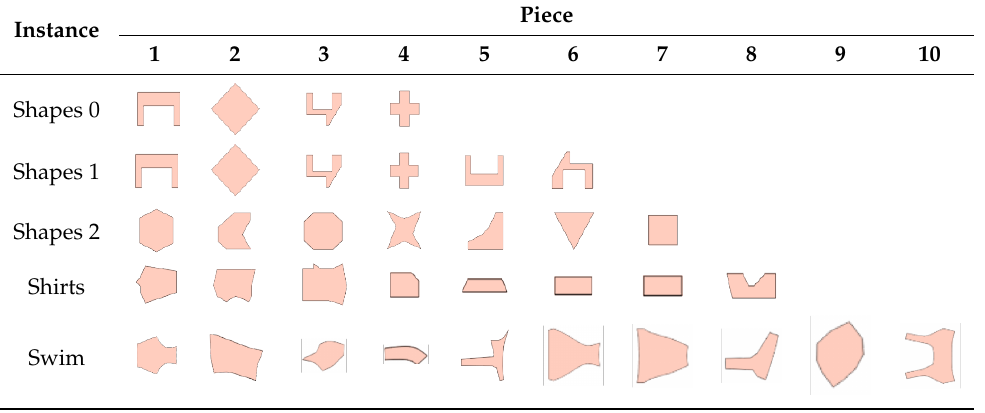
Table 6. Pieces used in each benchmark Table 6. Pieces used in each benchmark instance. Table 6. Pieces used in each benchmark instance. Table 6. Pieces used in each benchmark instance. Table 6. Pieces used in each benchmark instance. Table 6. Pieces used in each benchmark instance. Table 6. Pieces used in each benchmark instance. Table 6. Pieces used in each benchmark instance. Table 6. Pieces used in each benchmark instance. Table 6. Pieces used in each benchmark instance. Table 6. Pieces used in each benchmark instance. Table 6. Pieces used in each benchmark instance. Table 6. Pieces used in each benchmark instance. Table 6. Pieces used in each benchmark instance. Table 6. Pieces used in each benchmark instance. Table 6. Pieces used in each benchmark instance. Table 6. Pieces used in each benchmark instance. Table 6. Pieces used in each benchmark instance. Table 6. Pieces used in each benchmark instance. Table 6. Pieces used in each benchmark instance. Table 6. Pieces used in each benchmark instance. Table 6. Pieces used in each benchmark instance. Table 6. Pieces used in each benchmark instance. Table 6. Pieces used in each benchmark instance. Table 6. Pieces used in each benchmark instance. Table 6. Pieces used in each benchmark instance. Table 6. Pieces used in each benchmark instance. Table 6. Pieces used in each benchmark instance. Table 6. Pieces used in each benchmark instance.